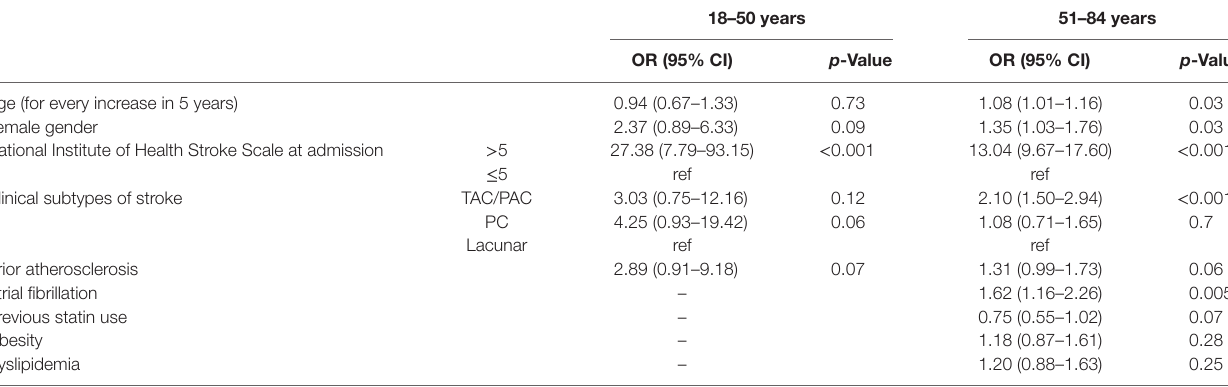
TaBle 4 | Independent predictors of severe disability (modified Ranking Scale > 3) or in-hospital mortality by age